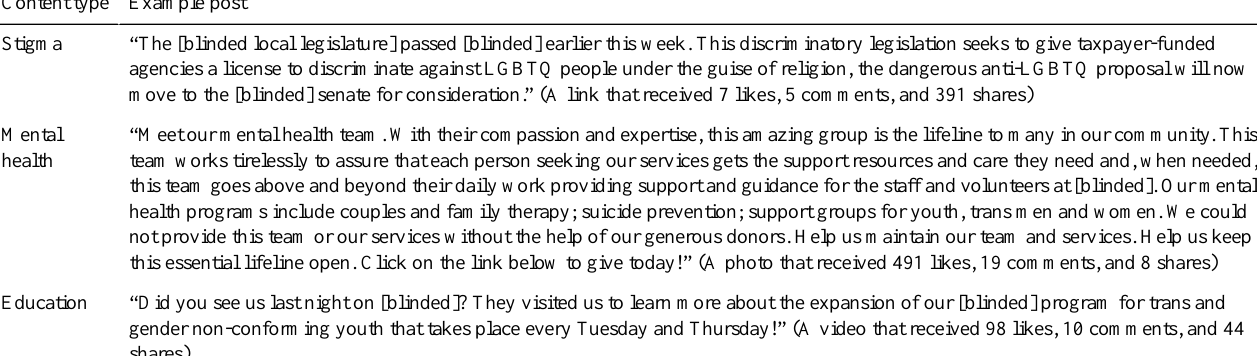
Table 2. Examples of Facebook posts by lesbian, gay, bisexual, transgender, and queer community centers classified by content type. Example postContent